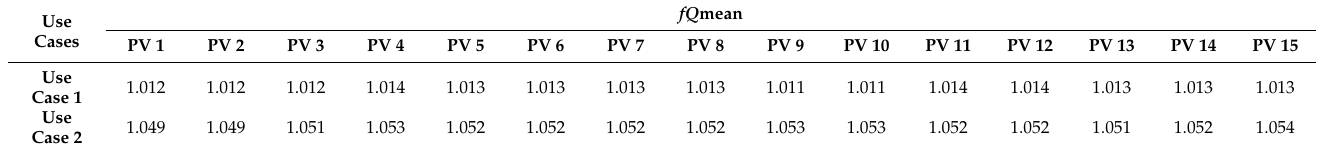
Table 1. Overview of mean values of sensitivity factors f Q mean for 15 PV units in the selected case study area Seebach